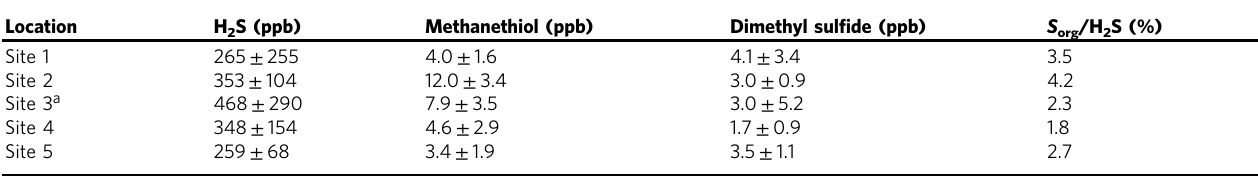
Table 2 Composition of sulfur compounds emitted from pig production facilities and the contribution of organic sulfur compounds relative to H 2 S Location